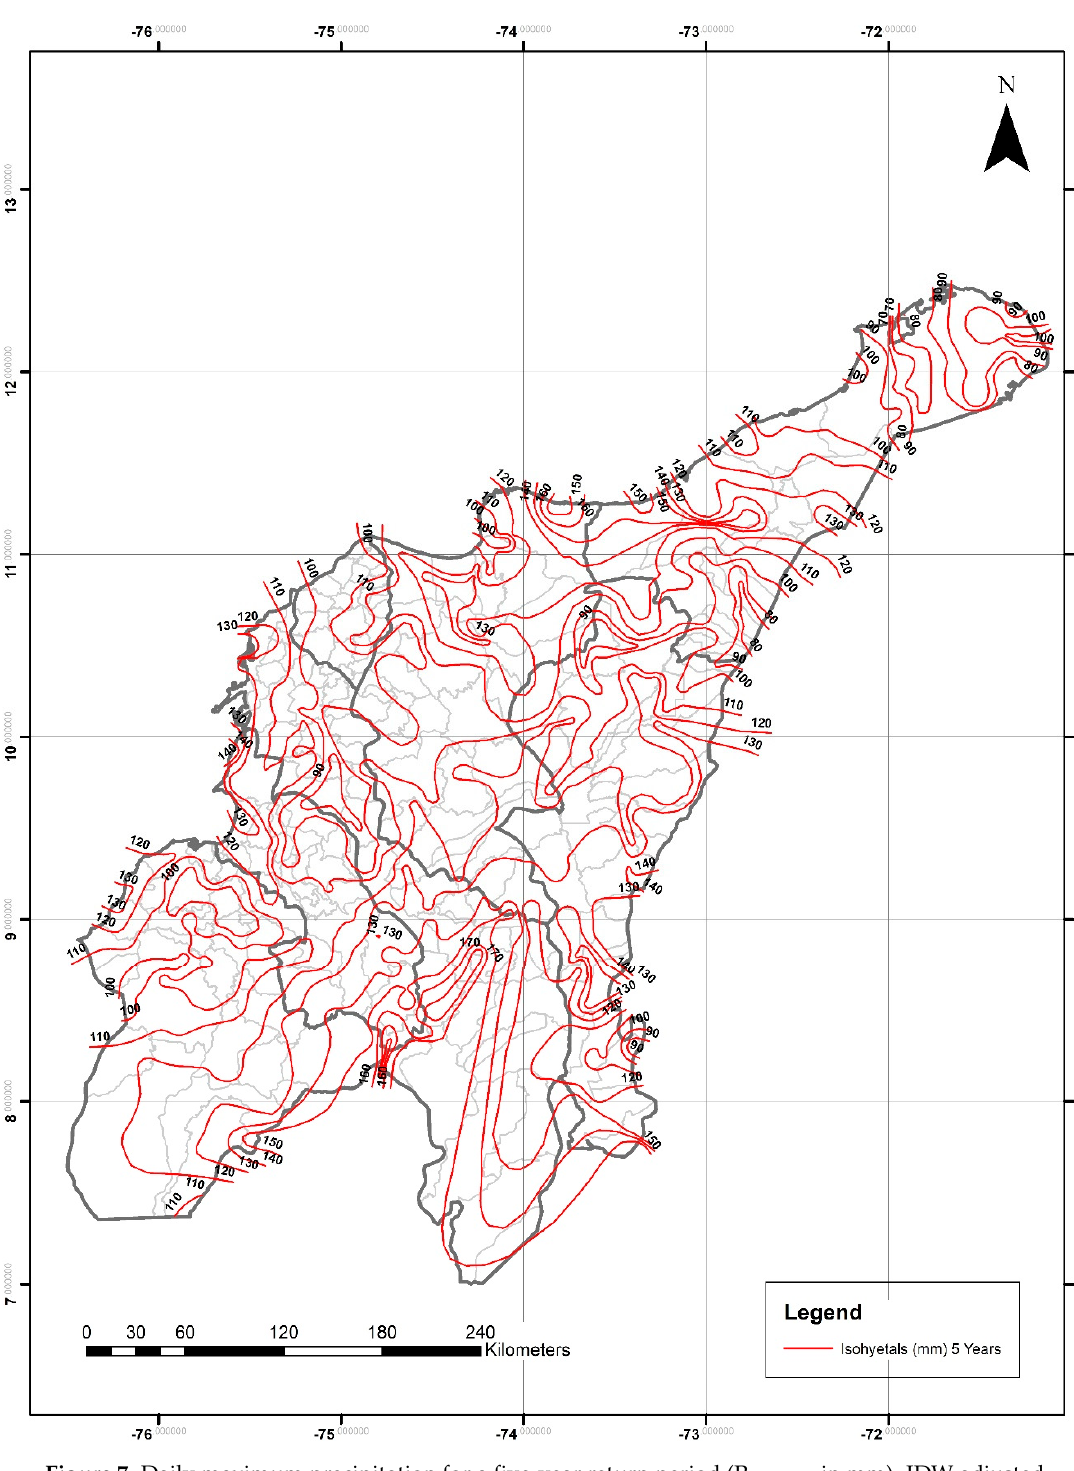
Figure 7. Daily maximum precipitation for a five-year return period (P 24h-max in mm). IDW adjusted method. Light-gray lines are the boundaries of the different municipalities within the departments.